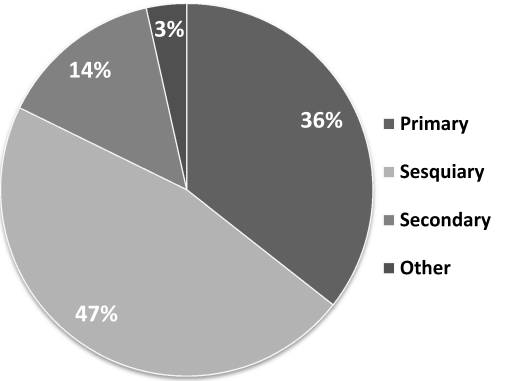
Figure 7. A breakdown of classification of Upper House election tweets (redefined